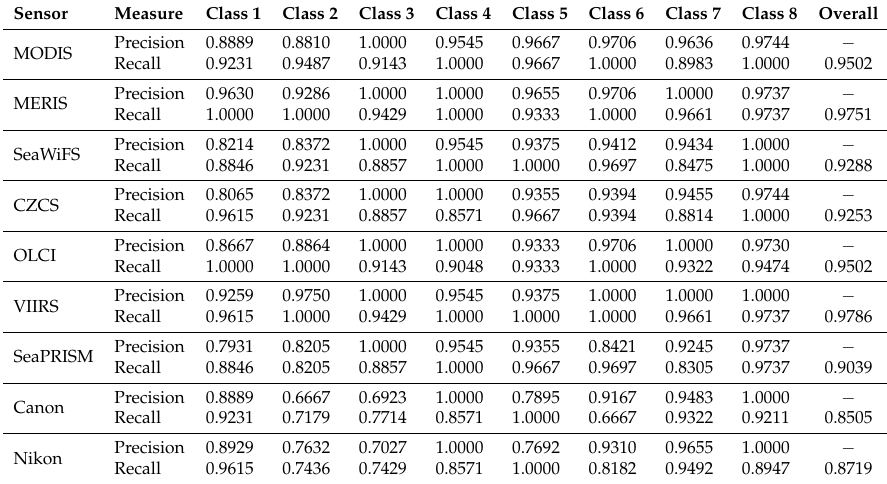
Table 3. Classification results using the proposed algorithm for Dataset